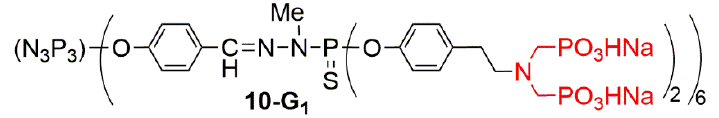
Figure 14. First generation dendrimer capped with azabisphosphonate functions.